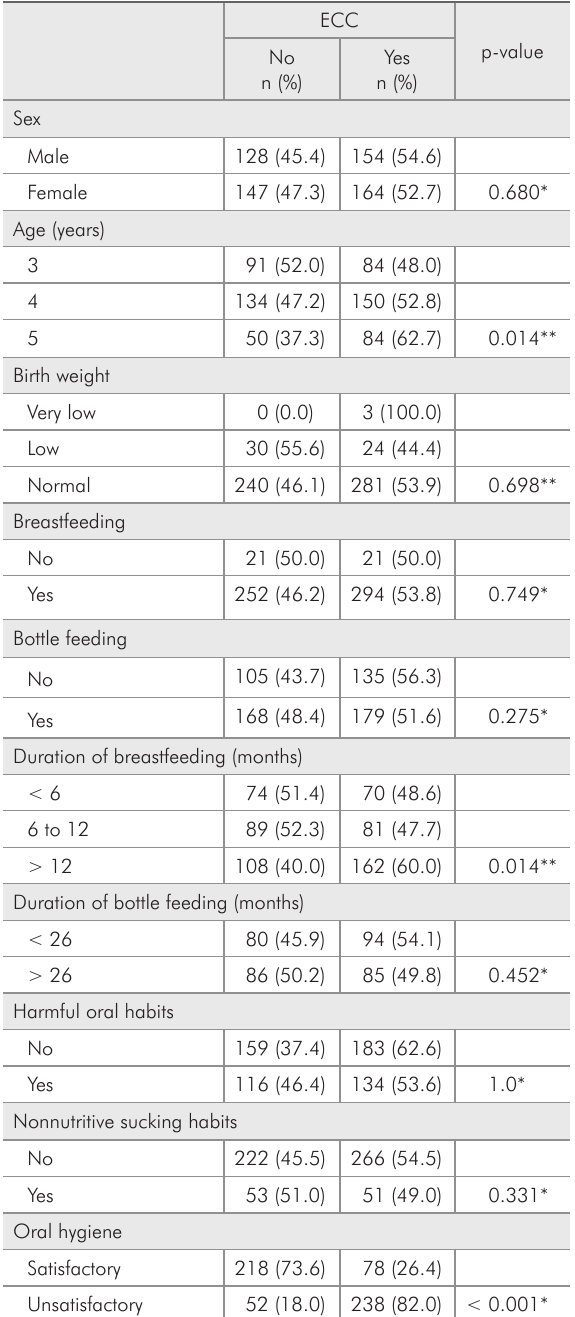
Table 1 - Distribution of ECC according to aspects related to the child. (continued on next